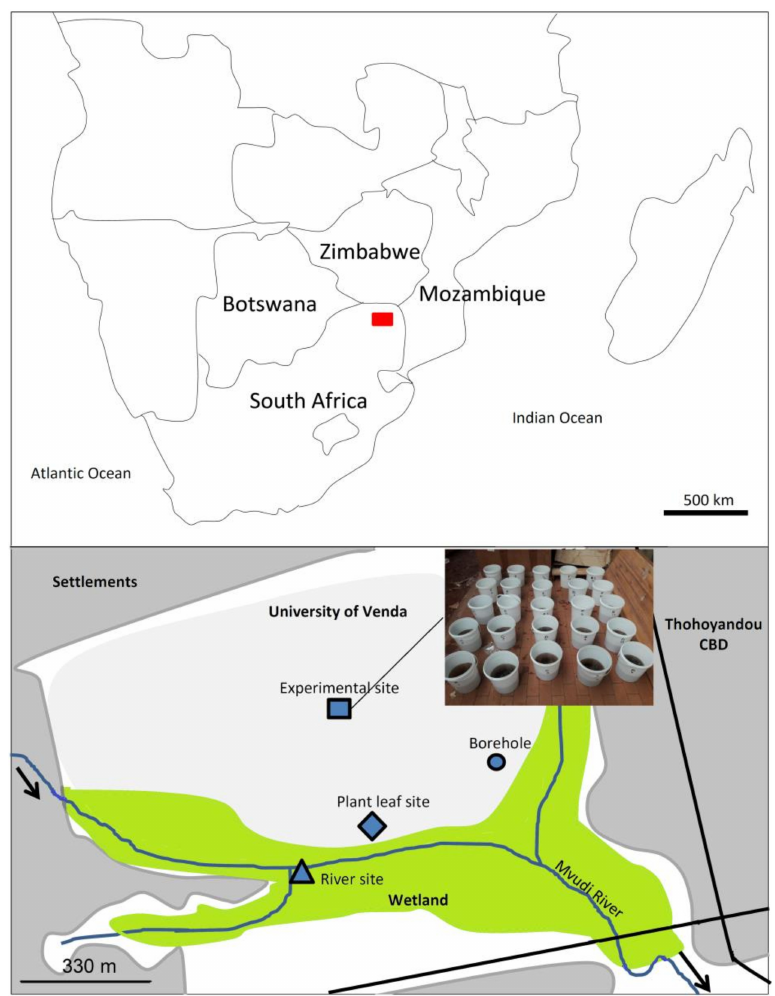
Figure 1. Location of the experimental site within the University of Venda (South Africa), the plant leaves and water collection sites. The bottom map illustrates the zone shown in red on the upper